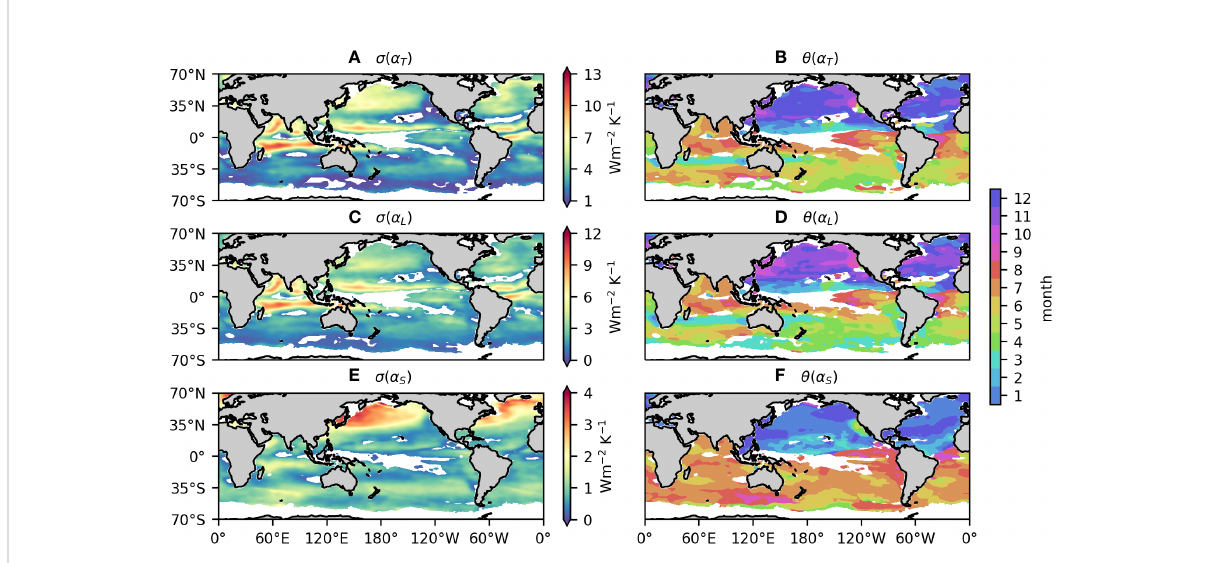
FIGURE 3 (A) Standard deviation and (B) peaking time of seasonal cycle of a T in the global ocean during 2008 – 2020. Here the peaking time of seasonal cycle is de fi ned as the month when a T reaches its maximum. Regions with statistically insigni fi cant seasonal cycles at the 95% con fi dence level or seasonally covered by the sea ice are masked by white. (C, D) and (E, F) Same as panels (A, B) but for a L and a S , respectively. Note that the colorbars are different for panels (A, C, E)